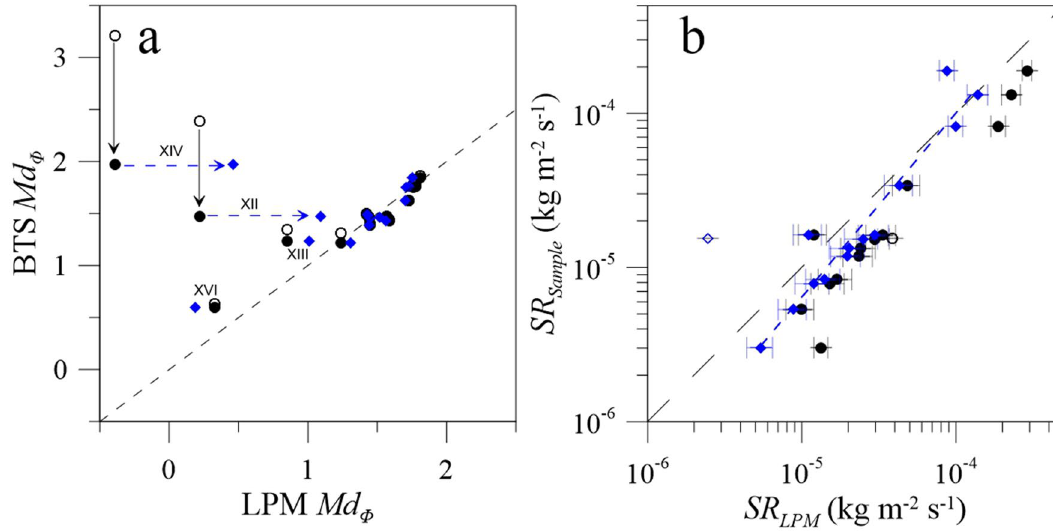
Figure 4. ( a ) Md Φ of the GSDs LPM from recorded tephra fallout as a function of Md Φ values of the GSD BTS based on collected samples. Open circles: raw GSDs LPM (including margin fallers); Black dots: GSD BTS for particles > 0.15 mm vs GSDs LPM with margin faller filter; Blue diamonds: GSD BTS for particles > 0.15 mm vs GSD LPM of individual particles (i.e., applying both the margin faller and the individual-particle lowest velocity filters); Black and blue arrows indicate the effect on Md Φ values of filtering particles below 0.15 mm in GSDs BTS and filtering the aggregates in GSDs LPM , respectively. The black dashed line is the one-to-one line. ( b ) Sedimentation Rate in kg m −2 s −1 computed based on sampling in trays (SR Sample ) and from the LPM records (SR LPM ) of all fallout events. Black: LPM data without margin fallers; Blue diamonds: SR LPM based on GSDs LPM with both margin fallers and individual-particle lowest velocity filter; The open symbol indicates event XII for which a large quantity of aggregates was observed in the LPM records (see Fig. 3b). The dashed blue line corresponds to a power-law between SR Sample and SR LPM for individual particles (see text for more details). Horizontal error bars of the mean differences of SR LPM for size classes whose width dD is ± 0.05 mm (see the “Materials and methods”